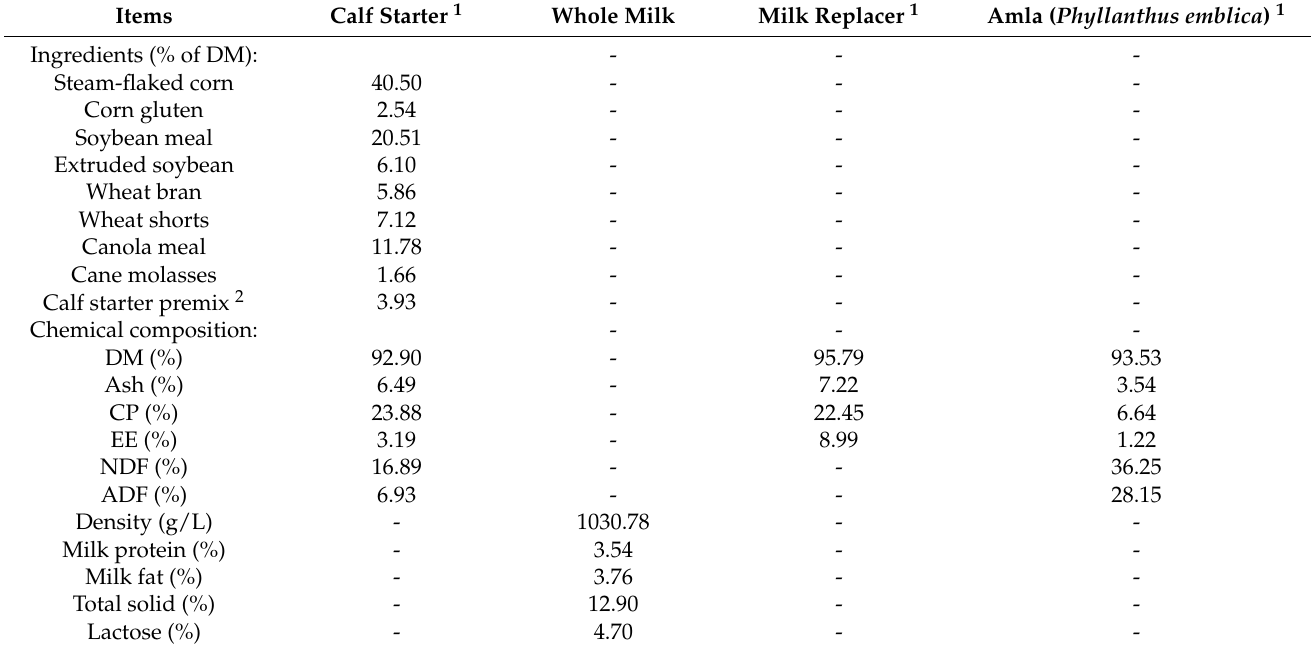
Table 1. Chemical composition of experimental diets used in the